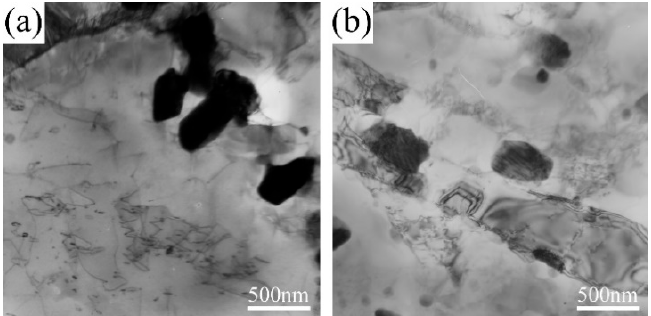
Figure 10. TEM micrographs of 9Cr-3W-3Co creep rupture specimens under stress of 120 MPa: ( a ) gauge, ( b ) grip.